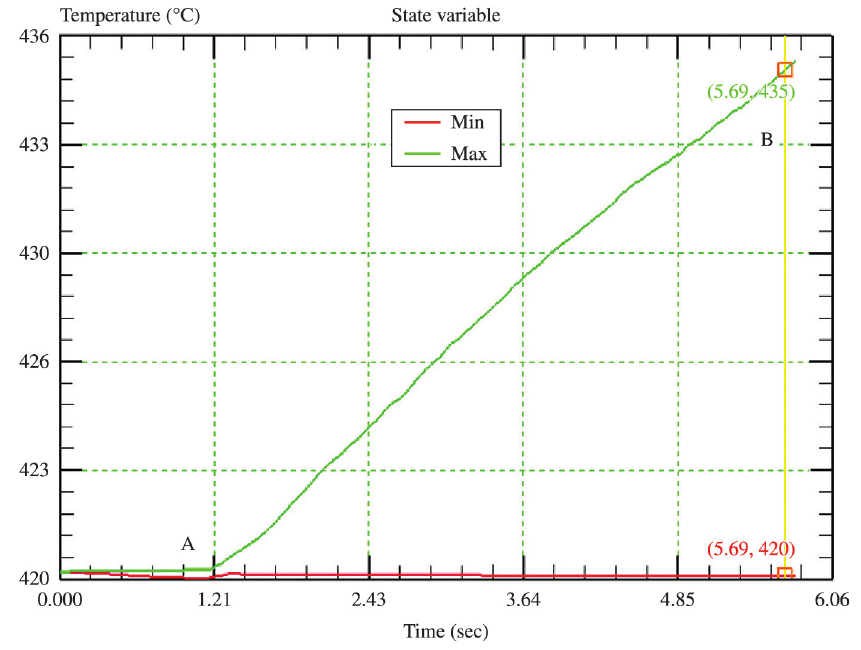
Figure 8. Maximum and minimum temperature in the workpiece throughout the ES process.